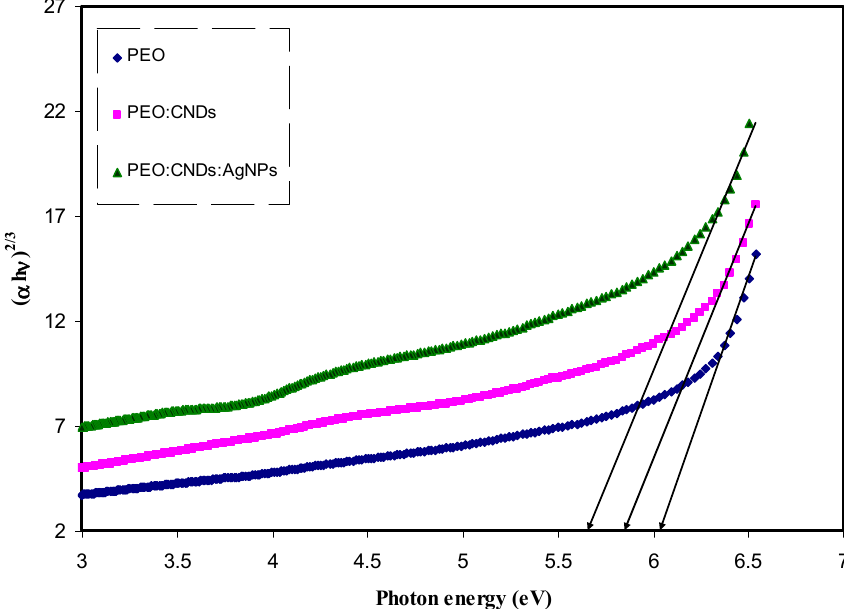
Figure 9. Plot of ( α h υ ) 2 vs. photon energy for pure PEO (PEPN0), PEO:CNDs (PEPN1), and PEO:CNDs:Ag (PEPN2) composite samples.